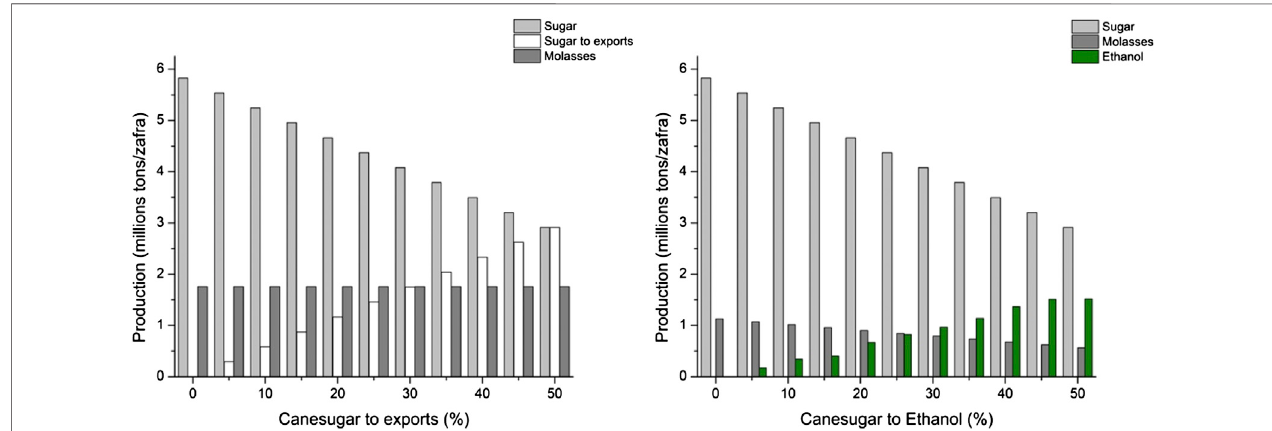
FIGURE 3 | Sugarcane products in scenario 1 for sugar to exports (left) and scenario 2 for sugar to ethanol (right) .